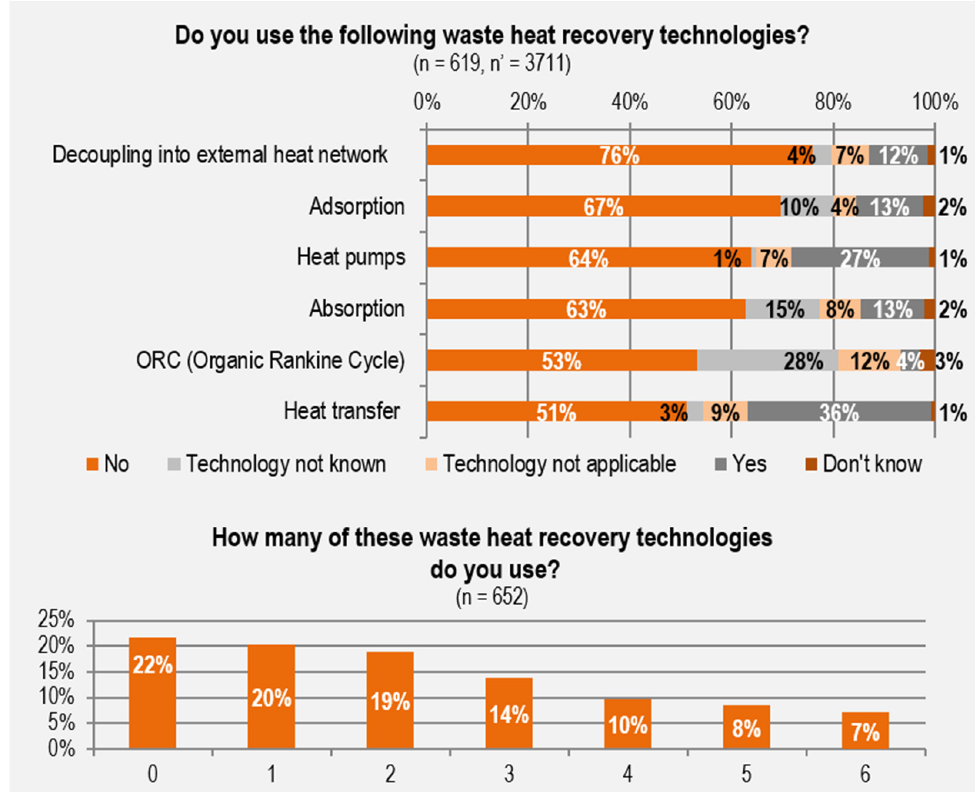
Figure 11. Waste heat recovery technologies used [42].